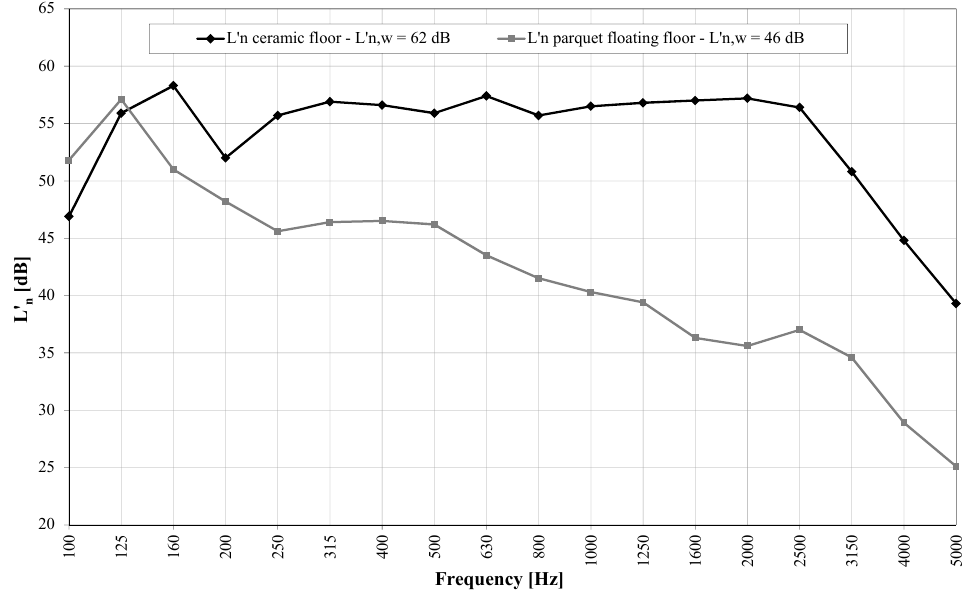
Figure 10. Impact sound pressure level ( L ’ or